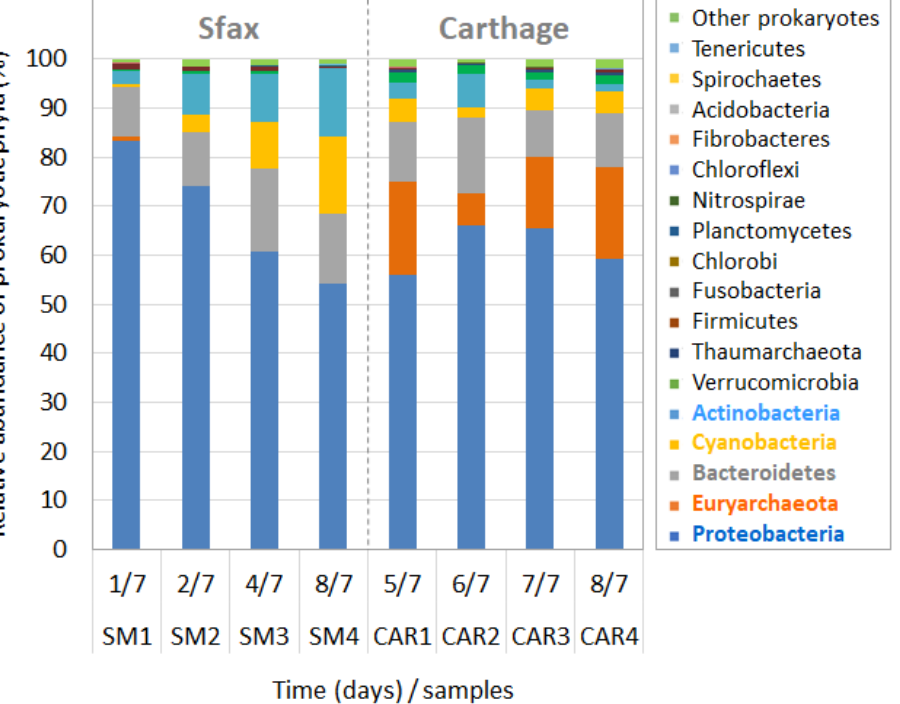
Figure 4. Compositions of prokaryotic communities at the phylum level in the waters of the Sfax site (Sidi Mansour (SM)) and the Carthage site (CAR) during dinoflagellate blooms. Differences in microbial community composition were observed at different taxonomic ranks between the SM and CAR sampling sites. At the phylum level, the contents of Pro- teobacteria (>50% on average) and Bacteroidetes (>10%) were similar, but Cyanobacteria and Actinobacteria were more abundant at Sfax than at Carthage (Figure 4). In addition, Euryarchaeota were abundant at CAR (>10–20%) but rare at SM (<1%). Marked differ- ences were observed at lower taxonomic levels, i.e., the order and family levels (Figure 5). The archaeal MGII group (>10%), Pelagibacterales (>10%), Rhodobacterales (>10%), and Flavobacteriales (>5%) clearly dominated at Carthage, while both archaeal MGII and Pelag- ibacterales were found in lower proportion at SM, with a dominance of Rhodobacterales (Rhodobacteraceae) and Chromatiales